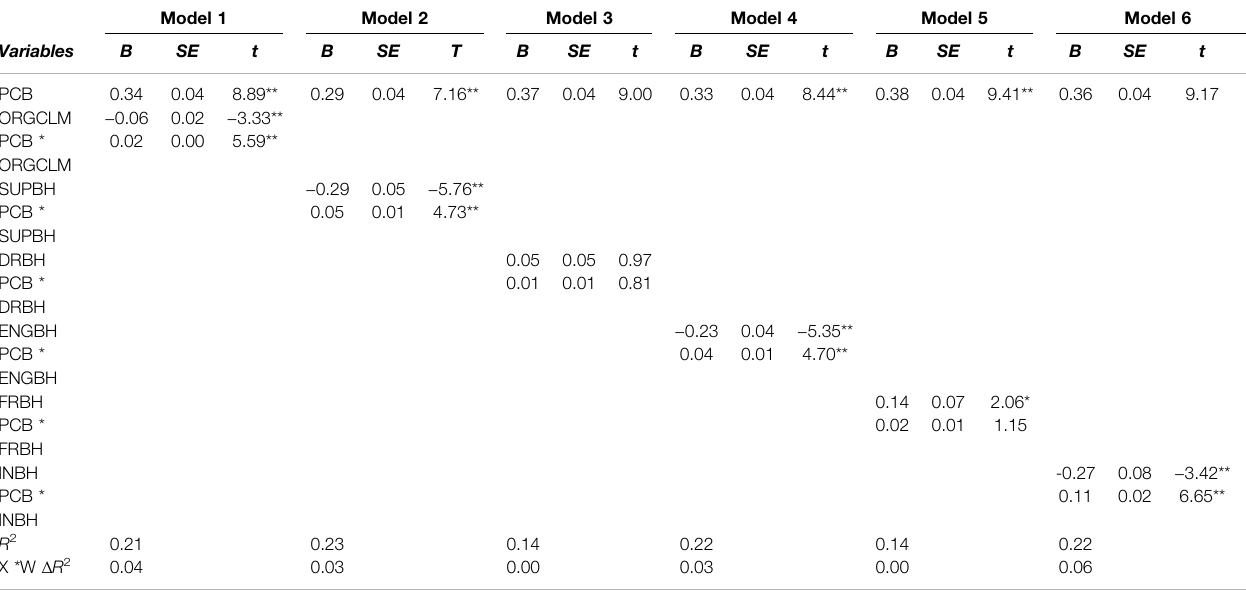
TABLE 2 | Hayes process regression predicting turnover intentions and testing moderating role of organizational